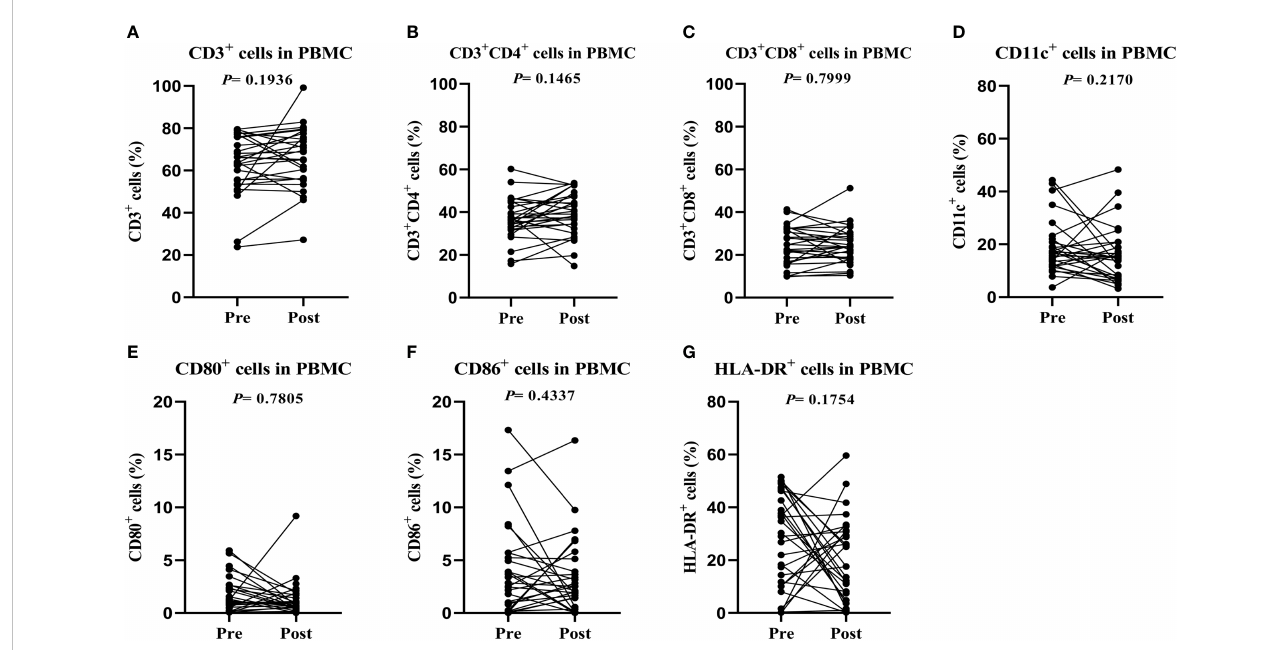
FIGURE 2 Peripheral blood samples have similar phenotypes before and after cytotoxic T lymphocyte infusion. (A) T lymphocyte proportions in peripheral blood. (B) Cytotoxic T lymphocyte proportions in peripheral blood. (C) Dendritic cell proportions in peripheral blood. (D – G) Activated T lymphocyte proportions in peripheral blood. Immunophenotypes were determined by fl ow cytometry.